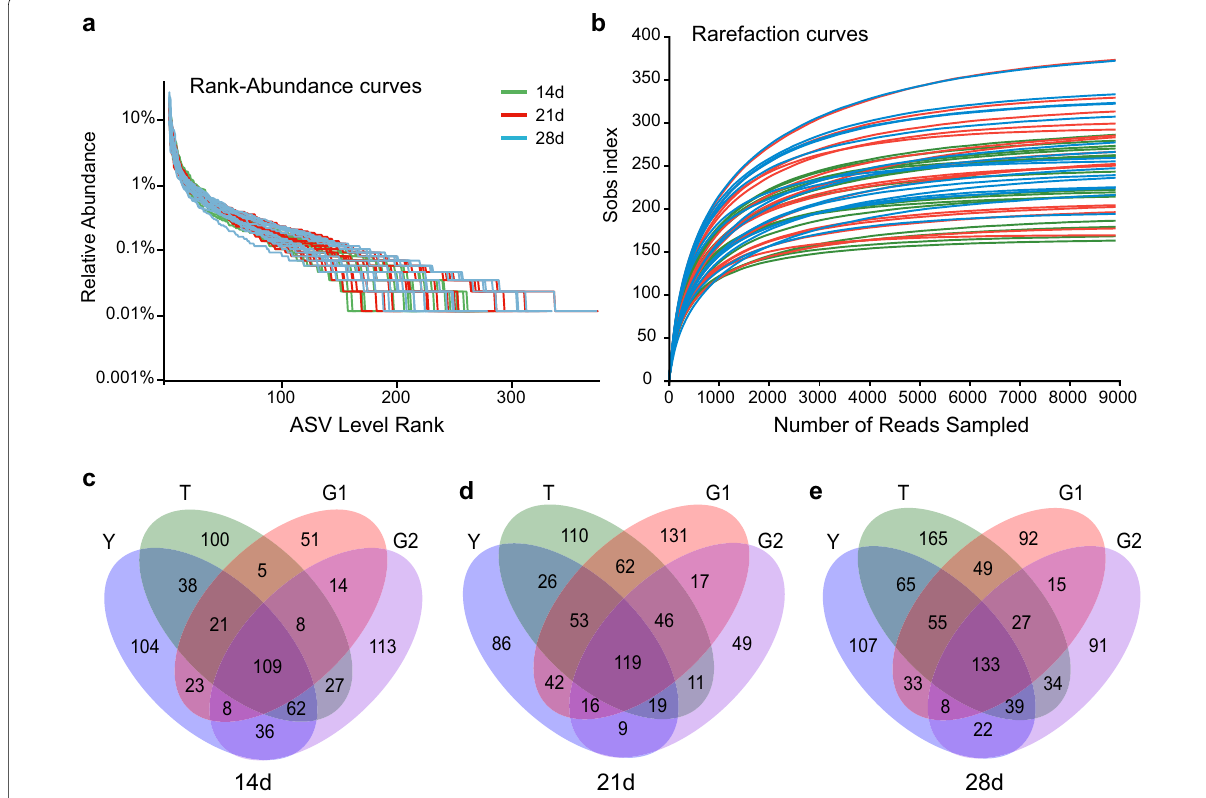
Fig. 3 Analysis of ASV level data by amplification sequencing. ASV level Rank-Abundance curves a , Sobs exponential dilution curves b , and Ven diagram c , d , e of samples. The richness of species in the horizontal direction of the Rank-Abundance curve is reflected by the width of the curve, and the smoothness of the curve reflects the evenness of species in the sample. Different colors represent different grouped samples. The sobs index rarefaction curve was constructed to reflect the microbial diversity of each sample at different sequencing quantities. Different colors rep-resent different samples. Venn diagram can intuitively represent the similarity and overlap of ASV components of samples. Different colors represent different grouped